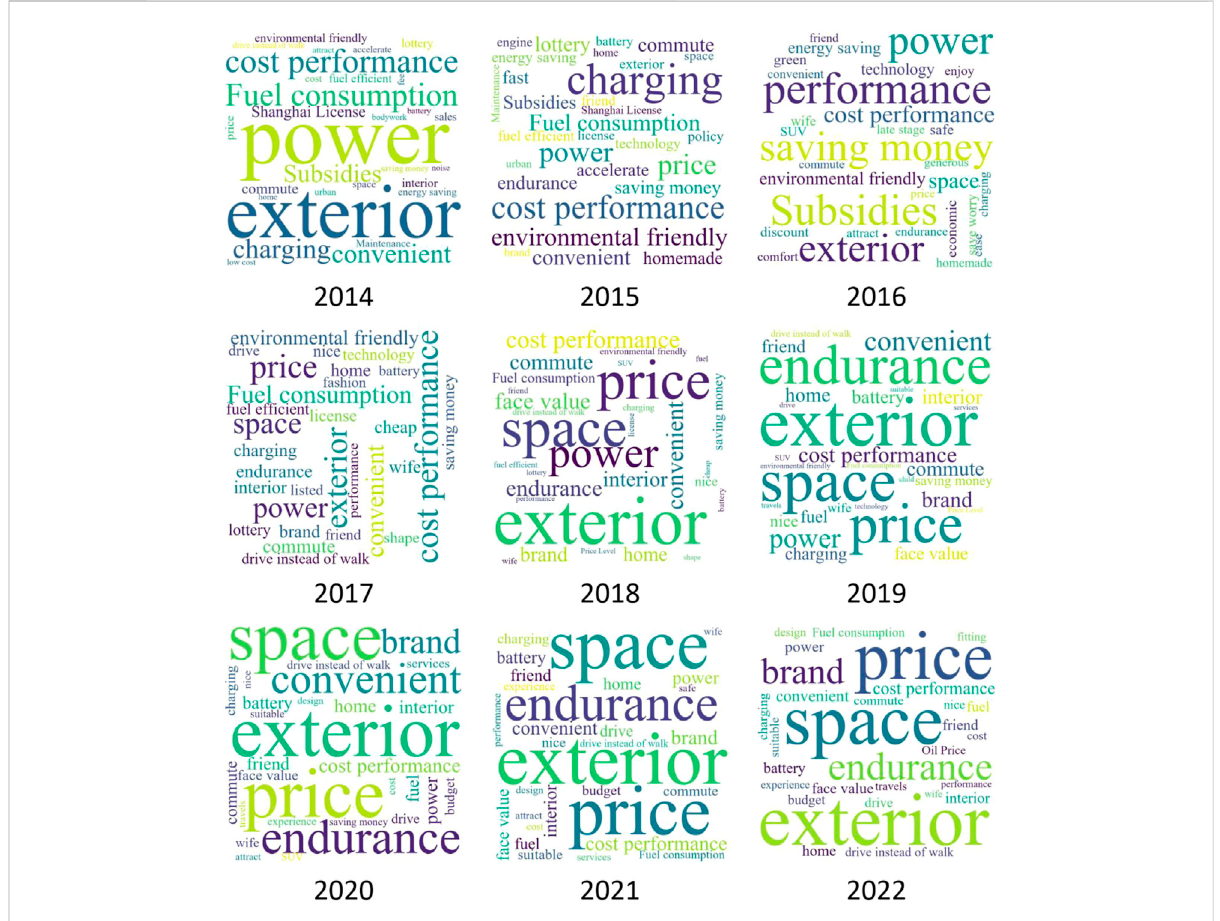
FIGURE 6 “ Reasons for choosing this car ” Word